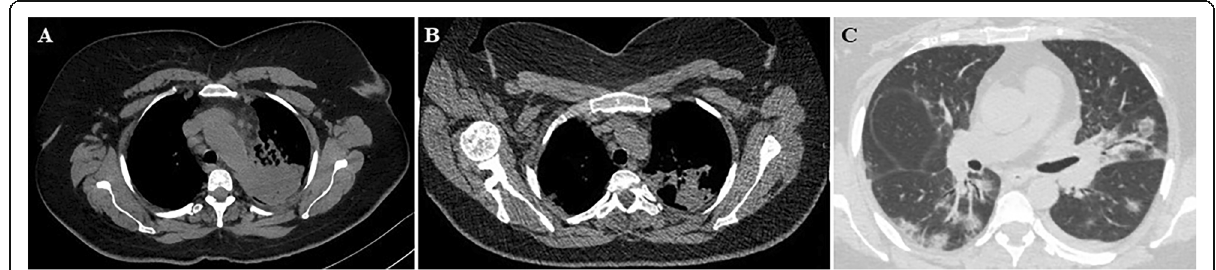
Fig. 1 CT imaging findings; a A mass like lesion was shown in the left upper lobe apicoposterior segment. b Dimensional regression of the mass like lesion and a consolidated area containing air bronchograms was observed in the left upper lobe apicoposterior segment 6 days later. c Follow-up CT scan 6 days later showed typical COVID-19 findings with multifocal segmental ground glass opacity infiltration and consolidation